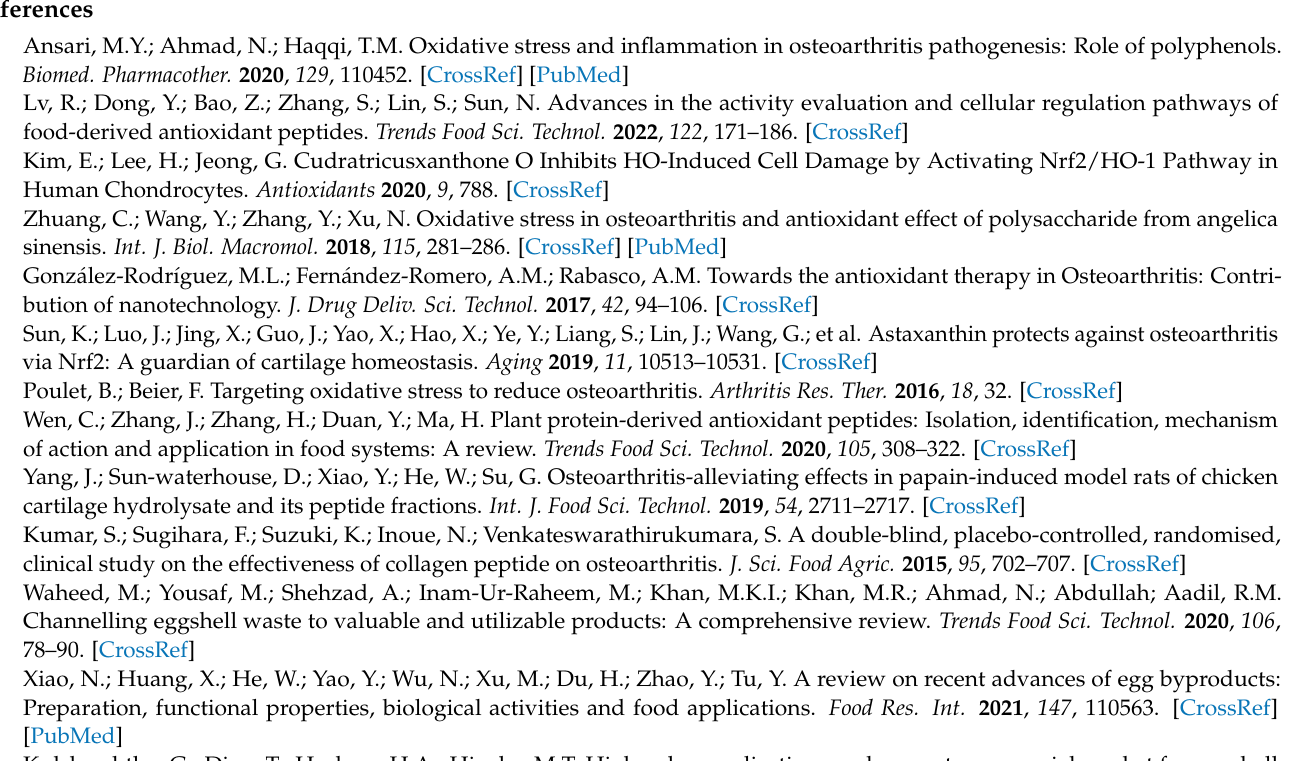
Figure S2: Molecular weight distribution of hatched eggshell membrane hydrolysates (A) and fresh eggshell membrane hydrolysates (B). Figure S3: The composition of amino acids (g/100 g) in hydrolysates of hatched ESM (HEMH) and fresh ESM (FEMH). The significance levels of * p < 0.05 and ** p < 0.01 are for FEMH versus HEMH at the same amino acid. Figure S4: Total ion chromatogram